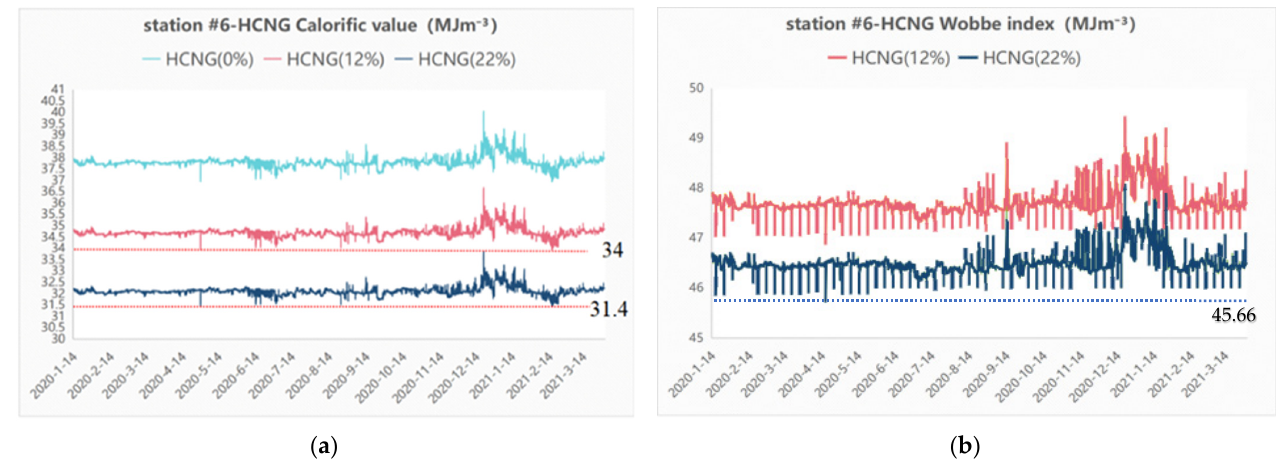
Figure 8. ( a ) Calorific value of natural gas source station #6 measured between 2020.1 and 2021.3 . ( b ) Wobbe Index of natural gas source station #6 measured between 2020.1 and 2021.3.